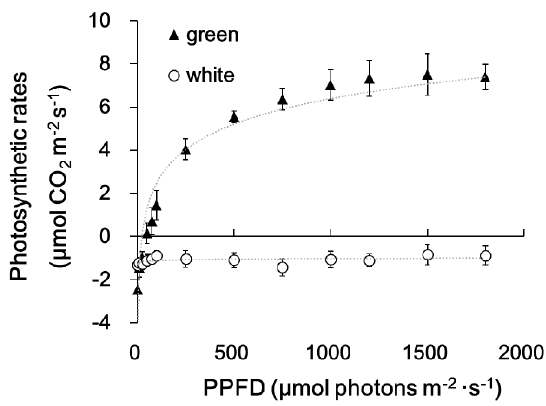
Figure 3. Light response curves of green and white sectors of milky stripe fig leaves. Leaf sectors were